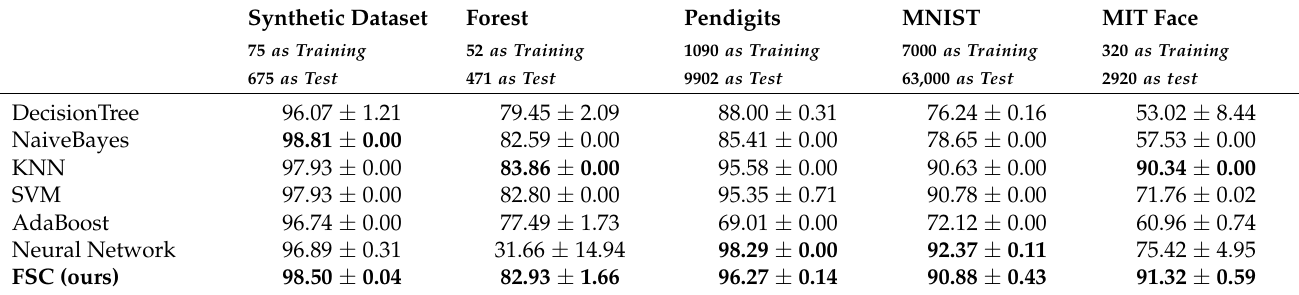
Table 6. The classification accuracy in percentage (mean ± standard deviation) of test set on five datasets (only 10% as training set). All results are the summary of repeated six runs. The best and second best results are in bold. Synthetic